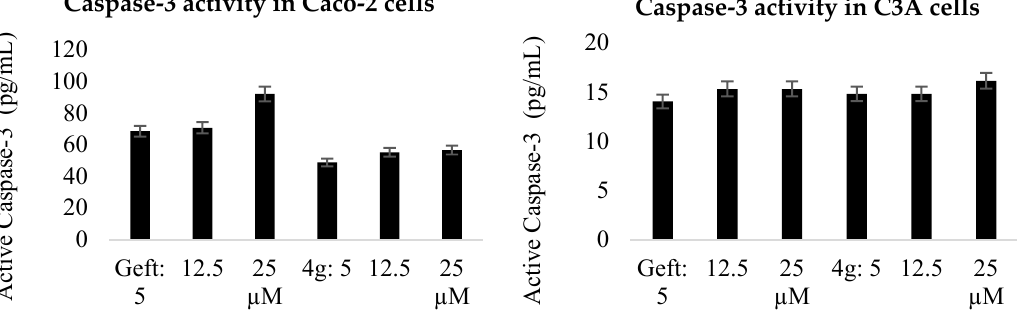
Figure 3. Effects of compounds EGFR on Caspace-3 activity in Caco-2 and C3A cells compared to gefitinib.